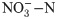

NO3--N in soil at different sampling dates during growing season.The data shown are the averages from 2011, 2012 and 2013 results of all three studied treatments. Error bars represent standard errors. Different letters above the bars indicate significant differences among sampling dates (p < 0.05).